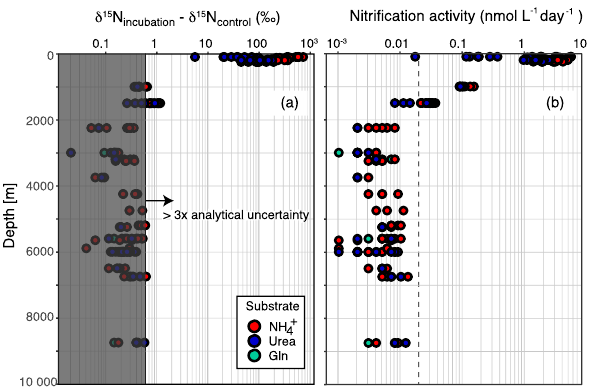
Figure 3. Vertical profiles of (a) δ 15 N N + N increase in cultivated batches from control batch after 15 N-spiked incubation and (b) ni- trification activity calculated based on the δ 15 N N + N differences. Since a δ 15 N N + N increase 3 times greater than analytical uncer- tainty (>0.6‰) is regarded as significant, symbols in the gray- shaded areas in panel (a) represent insignificant activity. Red, blue, and green symbols, respectively represent 15 N-labeled substrates of ammonium, urea, and glutamine. Horizontal axes are presented on a logarithmic